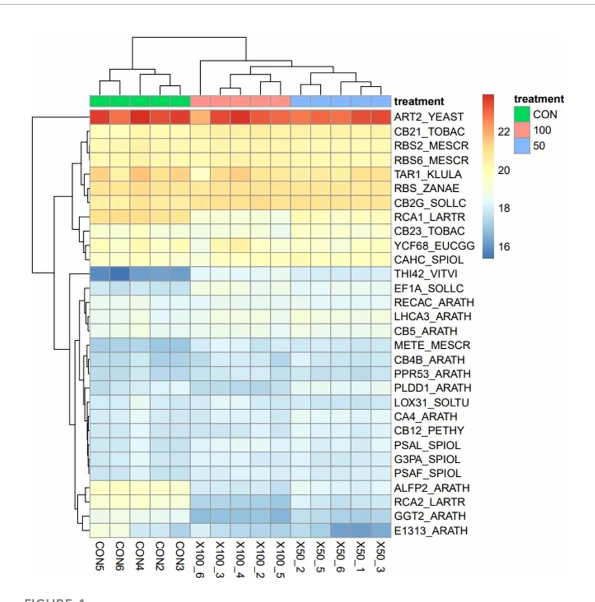
FIGURE 4 Heatmap using hierarchical clustering analysis for the top 30 most expressed